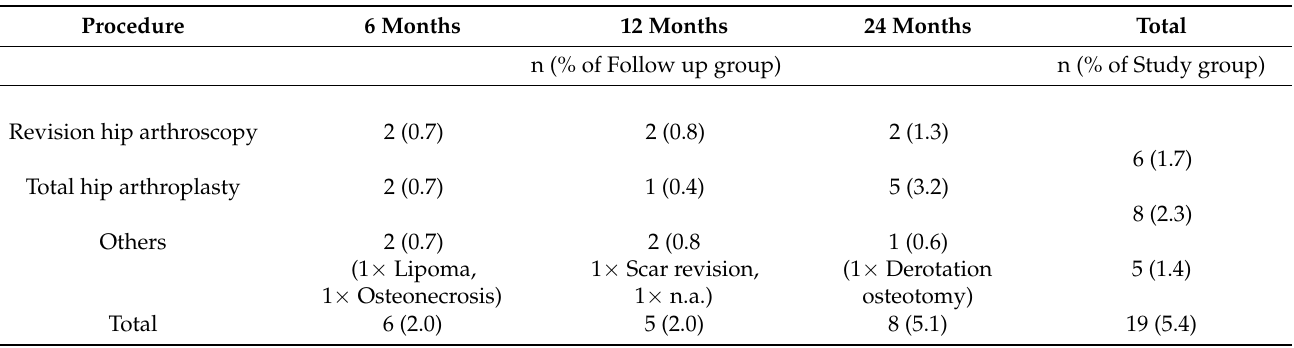
Table 2. Revision surgery. Frequency and type of revision surgery on the initially treated hip during the follow-up period.